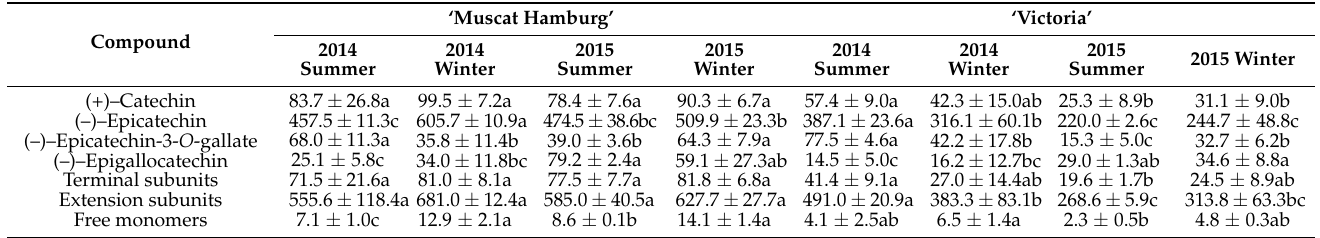
Table 4. Flavanol concentration (mg/kg FW) in ‘Muscat Hamburg’ and ‘Victoria’ grapes in 2014 and 2015 under the double cropping system.